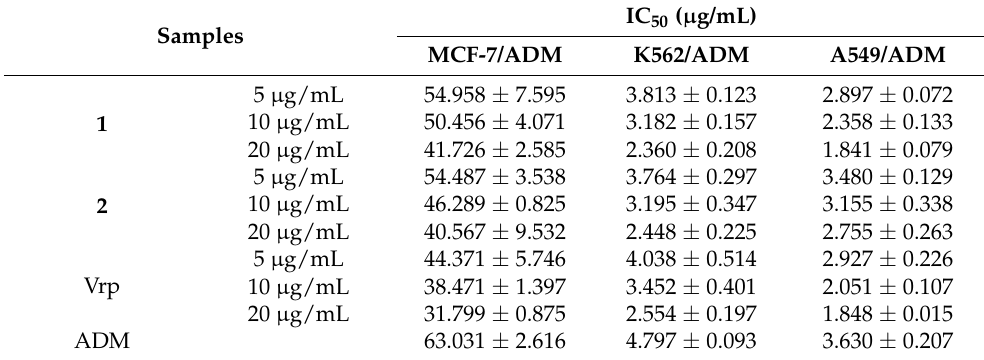
Figure 6. Inhibition ratios of ADM at different concentrations combined with compound 1 (PF70) at concentrations of 0, 5, 10 and 20 μ g/mL, respectively: ( A ) MCF-7/ADM; ( B ) K562/ADM; ( C ) A549/ADM; ( D ) Effect of 1 (PF 70) on P-gp expression. All experiments were performed in triplicate. ** p < 0.01.